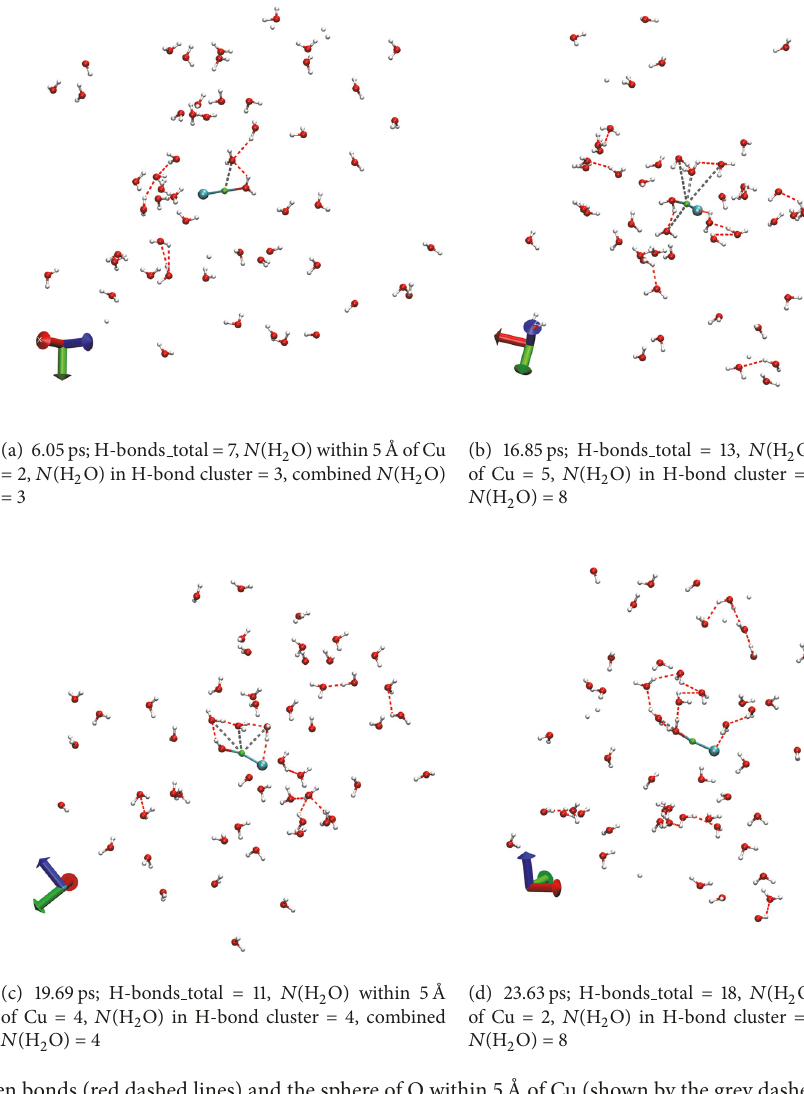
of water within 5 ˚A of the complex (2–5). The combined number of water molecules around [CuCl(H 2 O) 𝑛 ] 0 varies from 3 to